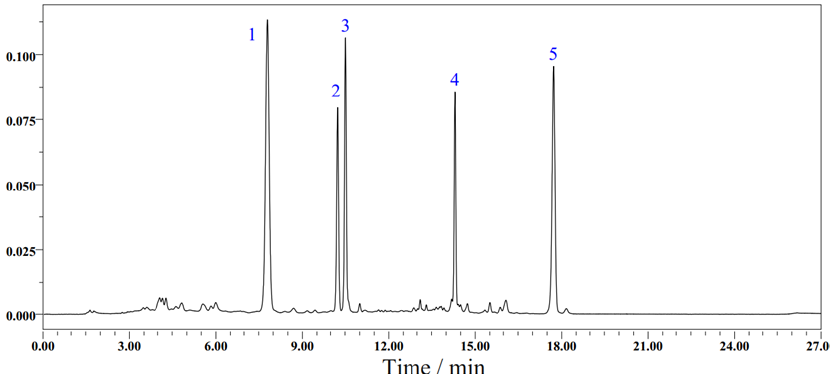
Figure 1. Chromatogram of capsanthin, zeaxanthin, lutein, β - cryptoxanthin and β -carotene under optimized HPLC method (1: capsanthin, 2: zeaxanthin, 3: lutein, 4: β - cryptoxanthin, 5: β -carotene).